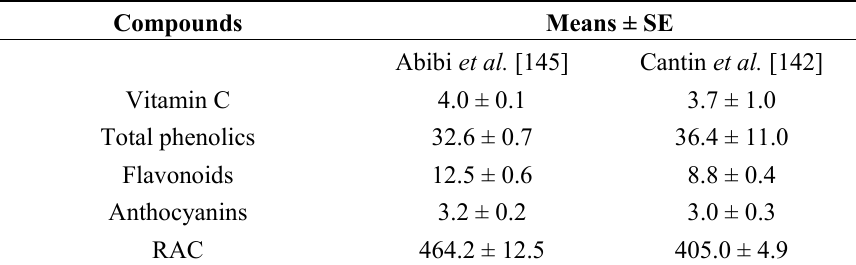
Table 3. Antioxidant molecule contents and relative antioxidant capacity (RAC) in fruit flesh of